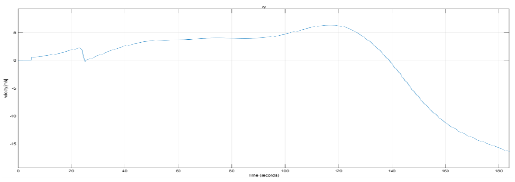
Figure 18. 2D (X-Z) view of Simulink Flight path of the QAV